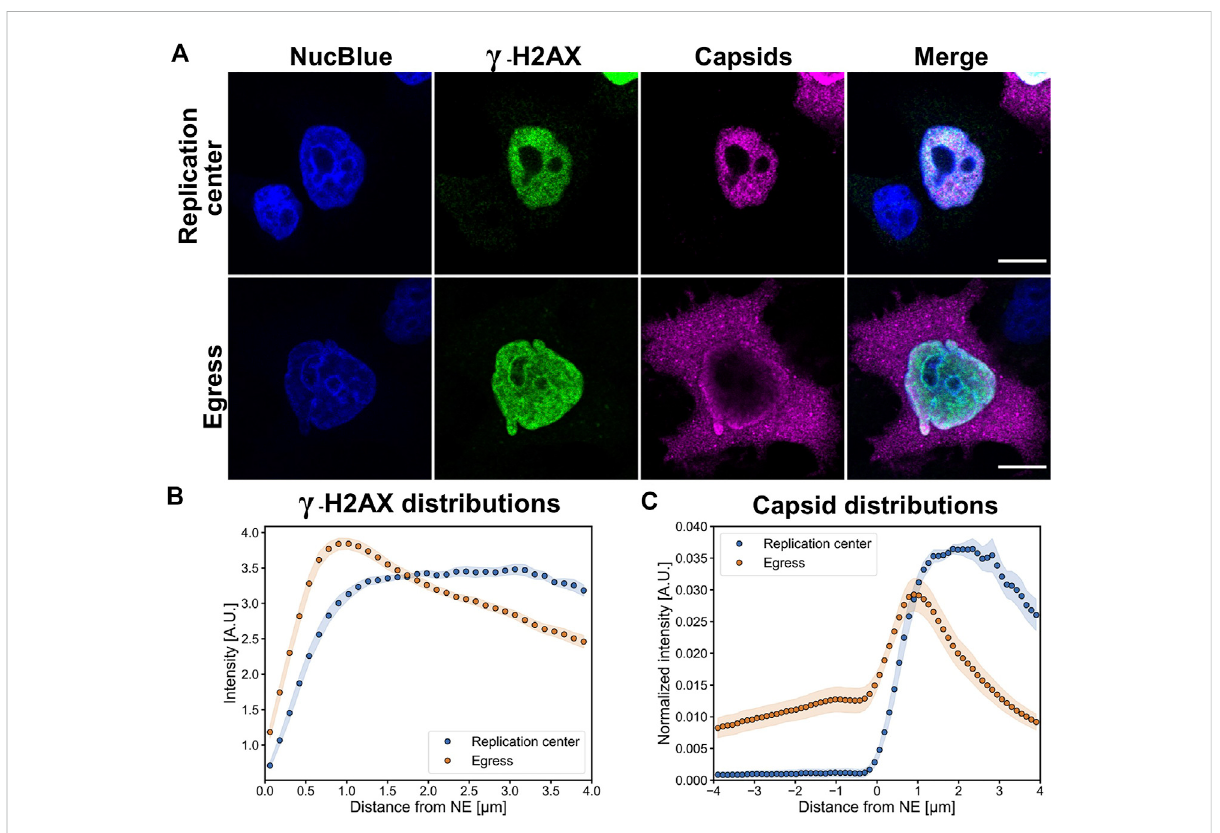
FIGURE 3 PerinuclearlocalizationofDNAdamageisaccompaniedbythenuclearescapeofviralcapsids. (A) Representativeconfocalimagesshowingthe distribution of DNA damage ( γ -H2AX, green) and viral capsids (magenta) in Hela cells at 24 hpi. The infected cells were divided into two main infection stages, de fi ned by nuclear accumulation of capsids (replication center) and localization both to the nucleus and cytoplasm (egress). The cells were immunolabeled with antibodies against intact capsids and γ -H2AX, and blue corresponds to NucBlue staining. Scale bars, 10 µm. (B) Quantitative analyses of the distribution of nuclear γ -H2AX and (C) cellular localization of capsids in replication center and egress class cells as a function of the distance from the nuclear envelope. The negative x -axis corresponds to the cytoplasmic and the positive to the nuclear side of the nuclear envelope. The shaded areas around the data points represent the standard error of the mean ( n =